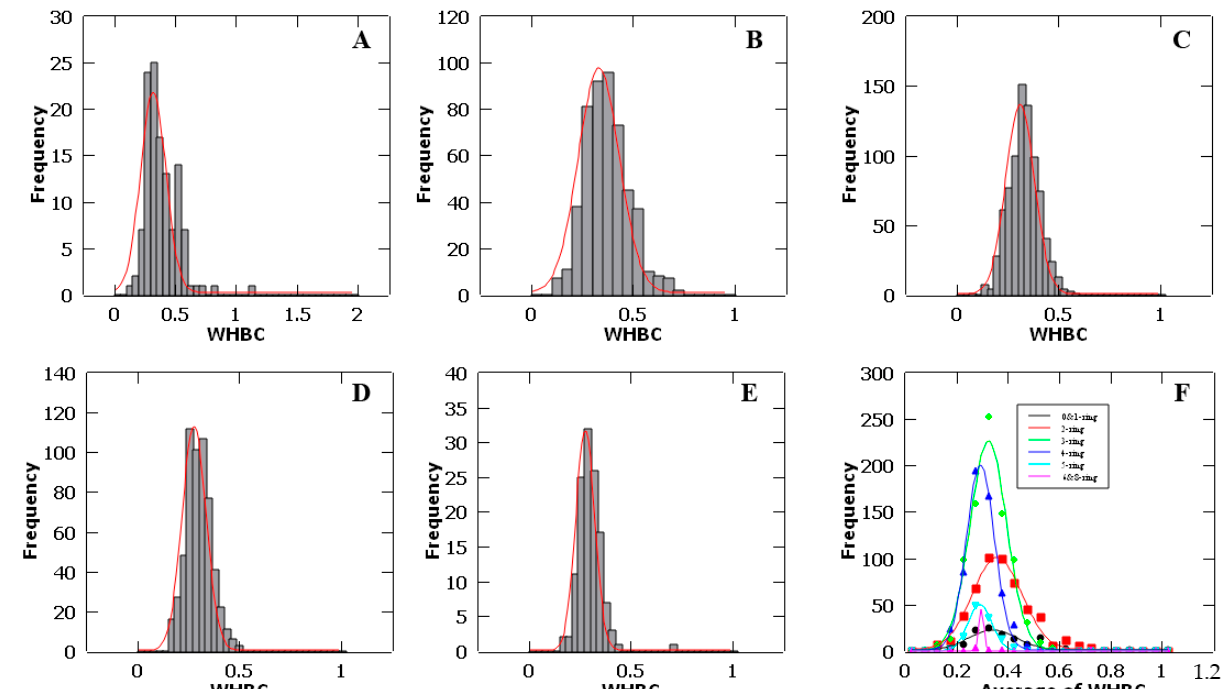
Figure 2. Histograms of the weighted hydrogen bond count (WHBC) for different classes of PKIs. ( A ) PKIs containing zero and one aromatic ring; ( B ) PKIs containing two aromatic rings; ( C ) PKIs containing three aromatic rings; ( D ) PKIs containing four aromatic rings; and ( E ) PKIs containing five and more aromatic rings. ( F ) Normal distribution of WHBC for different classes of PKIs.